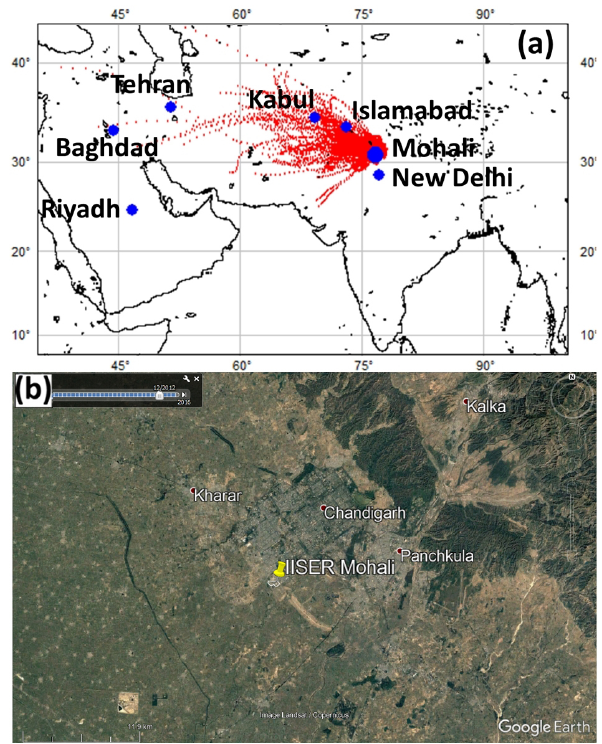
Figure 1. (a) Mohali, located on the Indian Subcontinent, with the overlaid 72h air mass back trajectories for May 2012 at 09:00 and 23:00LT (UTC+5:30) (b) Precise location of IISER-Mohali At- mospheric chemistry facility (30.667 ◦ N, 76.729 ◦ E, 310m above mean sea level, a.m.s.l.) with nearby cities on Google Earth© im- agery. The campus of IISER Mohali is outlined in